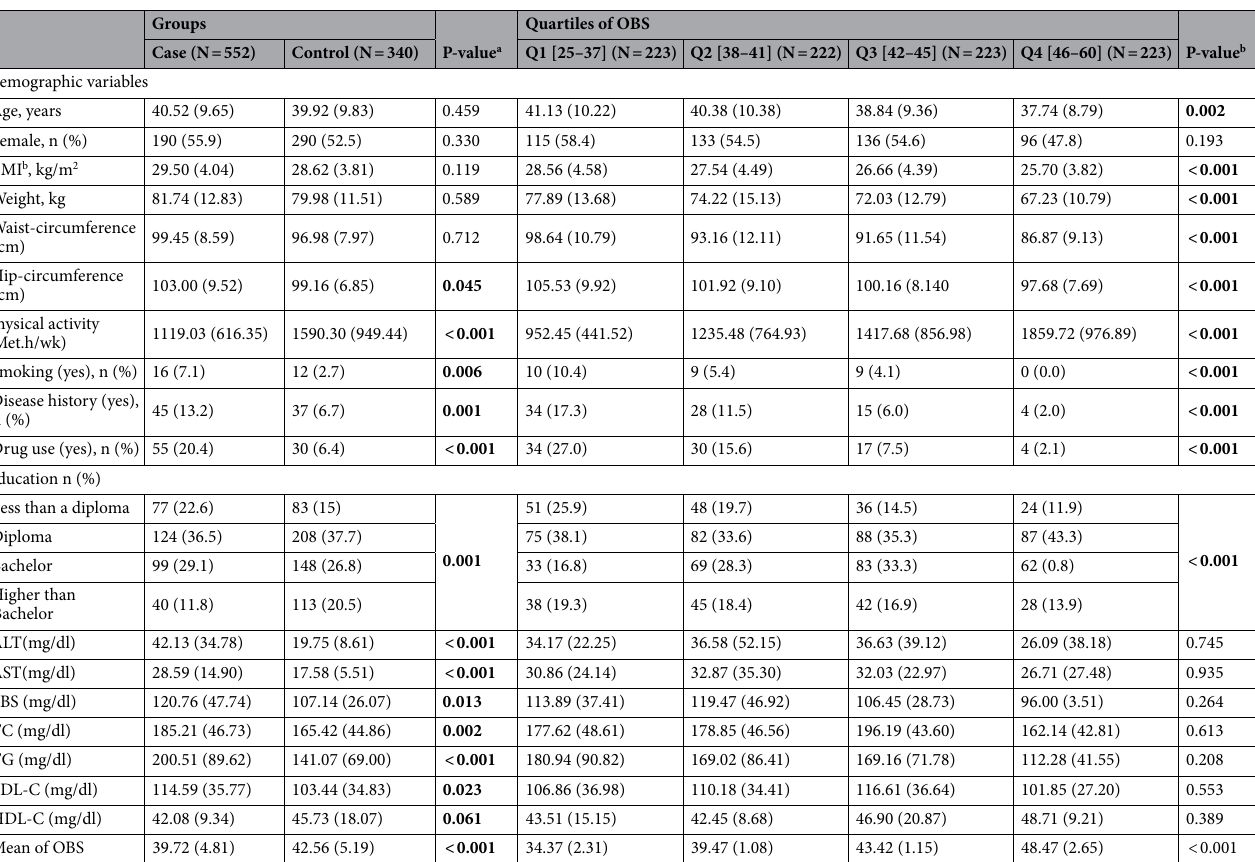
Table 1. Socio-demographic characteristics and anthropometric variables between groups and across the Quartiles of oxidative balance score (OBS). Values are expressed as means (standard deviation (SD)) of 892 subjects. Significant values are in bold. P-values are resulted from one way-ANOVA b Test or independent sample T-Test a for continuous variables and Chi-square for categorical variables. BMI body mass index, FBS fasting blood sugar, HDL-C high density lipoprotein-cholesterol, LDL-C low density lipoprotein-cholesterol, TC total cholesterol, TG triglycerides, AST aspartate aminotransferase, ALT alanine